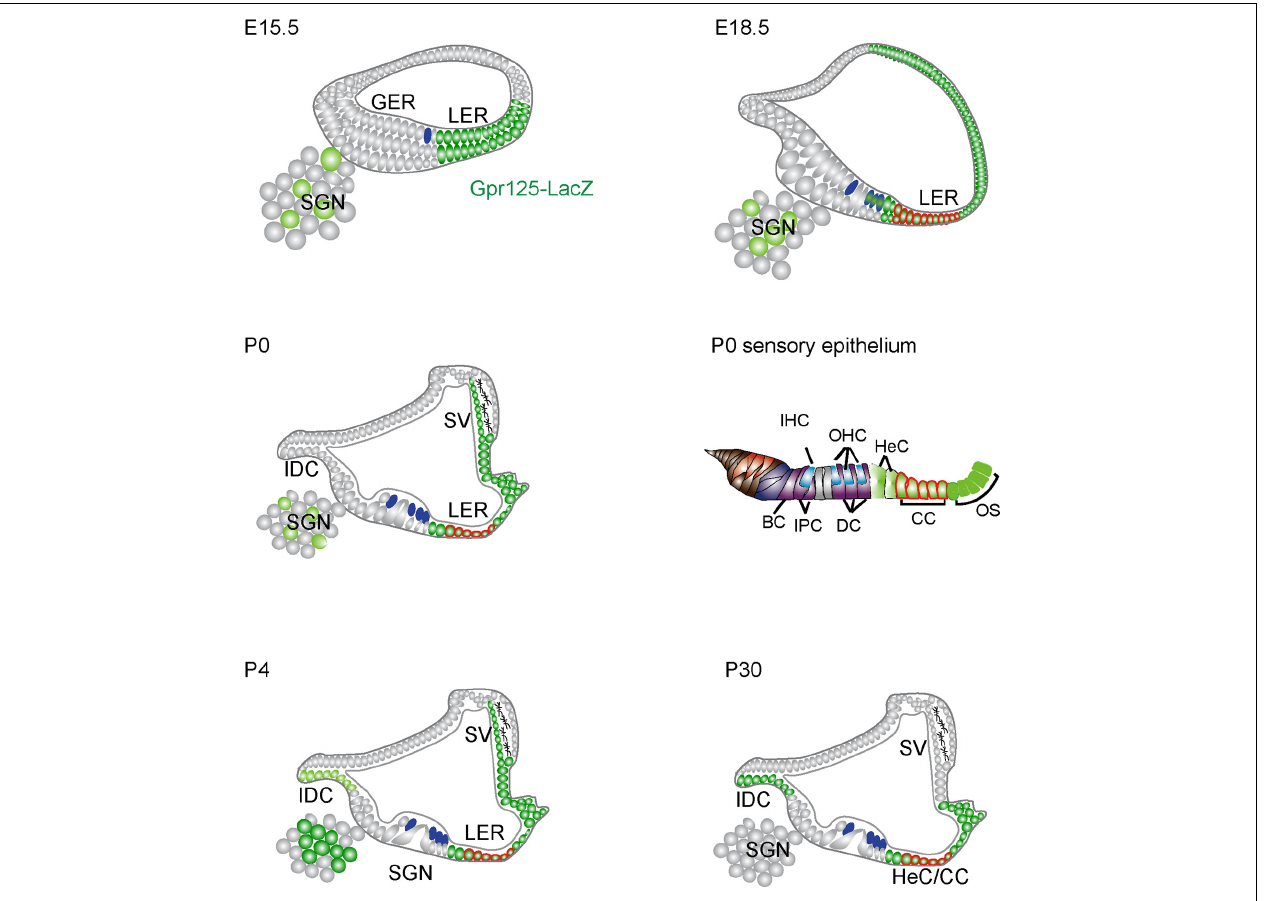
FIGURE 8 | Schematic depiction of Gpr125 expression in the developing and mature cochlea. At E15.5, Gpr125 is expressed in the LER, LW, and SGNs. At E18.5, Gpr125 is expressed broadly and strongly in the LER and lateral cochlear wall. It is expressed at lower levels in the OHCs and SGNs. At P0 and P4, Gpr125 is expressed in the LER, SV, and SGNs. The IDCs do not express Gpr125 at P0 and display robust expression later at P4 and P30. At P30, Gpr125 is expressed in the Claudius cells, Hensen’s cells, and outer sulcus, but is no longer expressed in the SV and SGNs. SGN, spiral ganglion neurons; GER, greater epithelial ridge; LER, lesser epithelial ridge; SV, stria vascularis; OHC, outer hair cells; IHC, inner hair cells; HC, Hensen’s cell, IDC, interdental cell; IPC, inner phalangeal cells; PC, pillar cells; DC, Deiters’ cells; CC, Claudius’s cells; OS, outer sulcus cells; BC, border